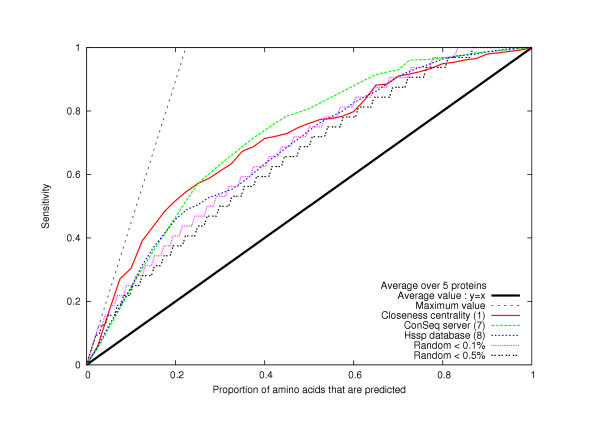
Comparison between phylogenetic, random and network methods. We compare method 1 (based on closeness centrality) with two phylogenetic methods (method 7 -Hssp database- and method 8 -Conseg server-) and with a random selection of the amino acids. There is a probability less than 1% (resp. 0.5%) that a random selection of the amino acids will produce a curve over the "Random <1%" curve (resp. "Random <0.5%" curve). We notice that if we predict between 10% and 50% of the amino acids, there is a probability less than 0.5% that a random selection of the amino acids will give better results than methods 1 and 7. The calculations are made as an average over the five networks representing HIV-1 protease, TEM1 beta-lactamase, T4 lysozyme, Barnase and the bacteriophage f1 gene V protein.